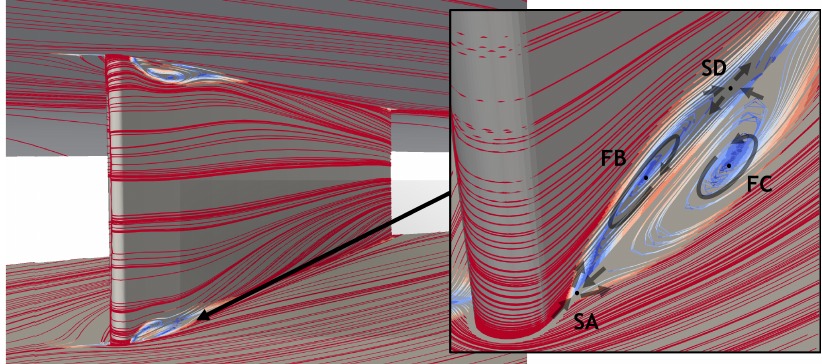
Figure 10. Skin friction lines colored by the velocity magnitude at the first cell. From minimum to maximum: blue to red.